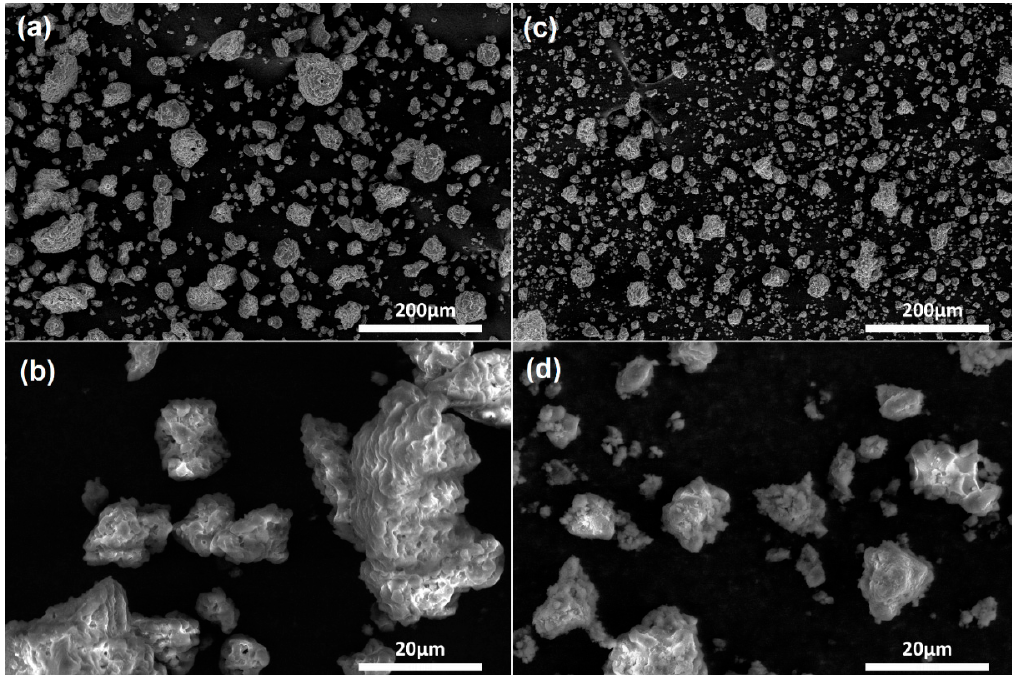
Figure 4. SEM images of ( a , b ) the lignin and ( c , d ) lignin + PVP samples at different magnifications.